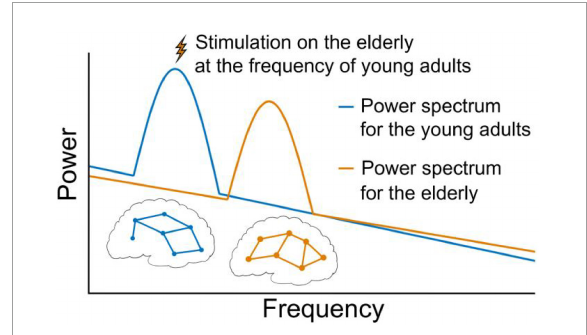
FIGURE1 Illustration for the perspective. The overall power and frequency patterns in healthy brain signals follow the scale-free law in which power is proportional to 1/frequency. There are also some oscillations (e.g., the two peaks on the power spectra) of brain signals which correspond to different network patterns (e.g., the two networks in the figure). Due to the shift of frequency between adjacent frequency bands and/or temporal dedifferentiation among multiple bands, the decrease in the efficiency of neural activity and related functional declines are often observed in aging brains. The application of rhythmic brain stimulation to modulate the natural frequency in aging group to that of younger brains may thus help retard the decline of brain functions by reversing neural activities in aging brains to their younger and healthy